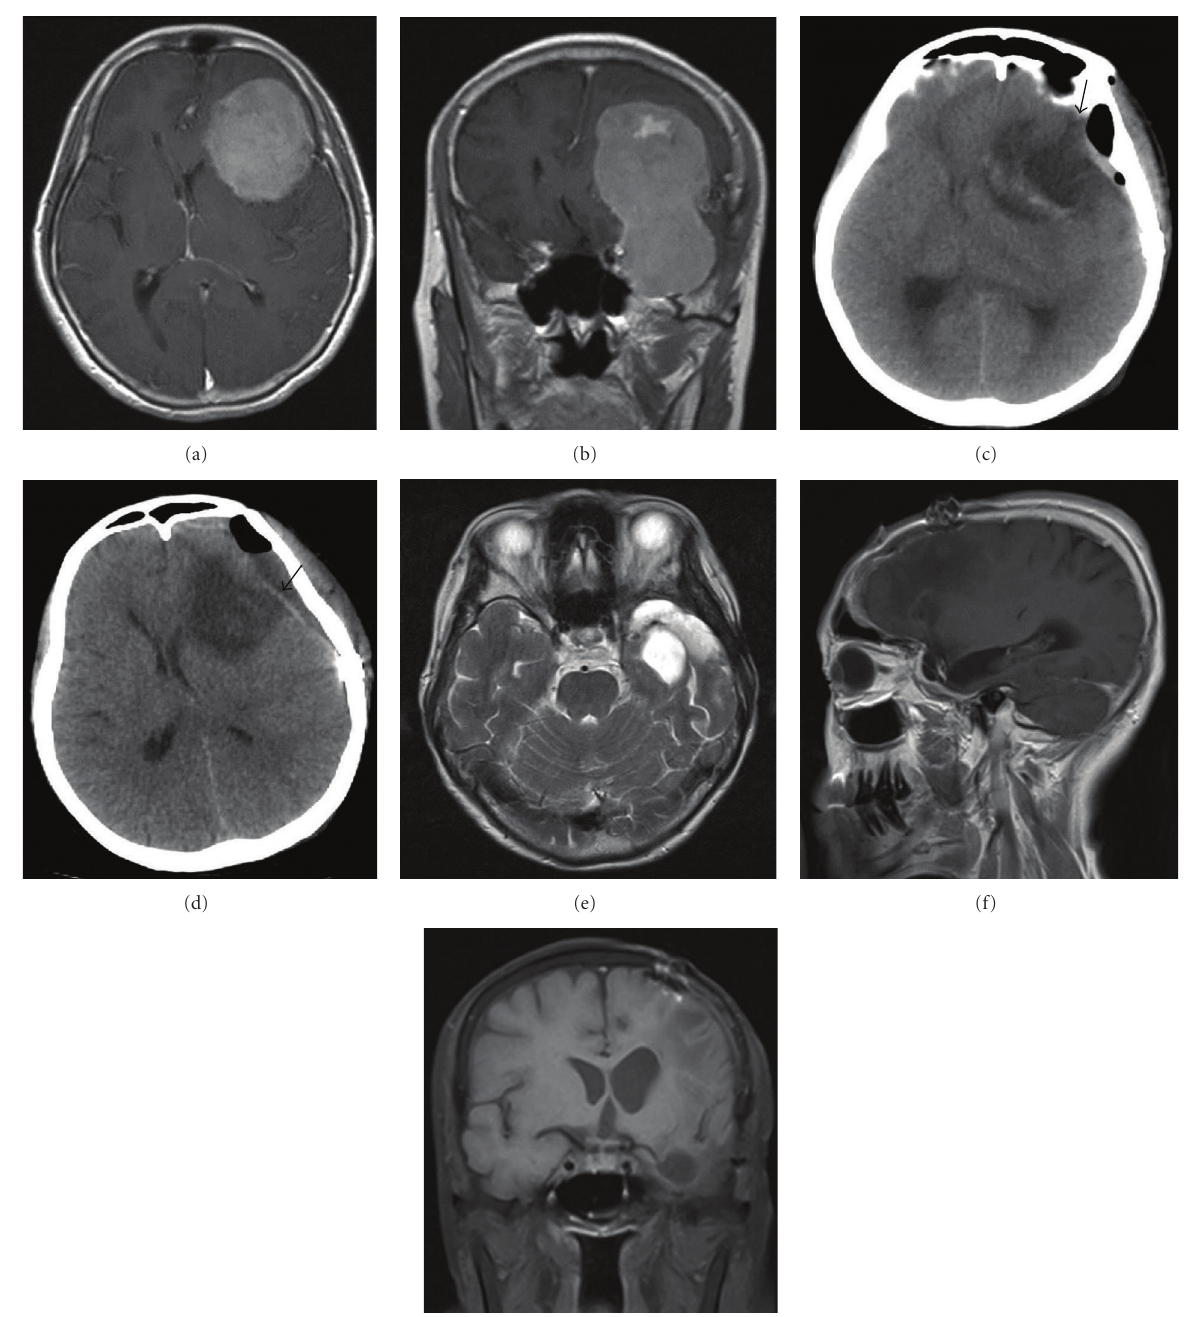
Figure 2: Imaging results for Case 2. (a)-(b) MRI showing sphenoid ridge meningioma. (c) CT revealing cyst formation in the tumor resection cavity 6 days after tumor resection. The arrow indicates the narrow roof region of the tumor resection cavity, where the “valve”-like structure is located. (d) Recommencement of e ff usion in the tumor cavity 1 week after the reoperation. The arrow indicates that the roof region of the tumor resection cavity became widened. (e)–(g) MRI showing disappearance of cyst formation in the tumor resection cavity 10 months after the